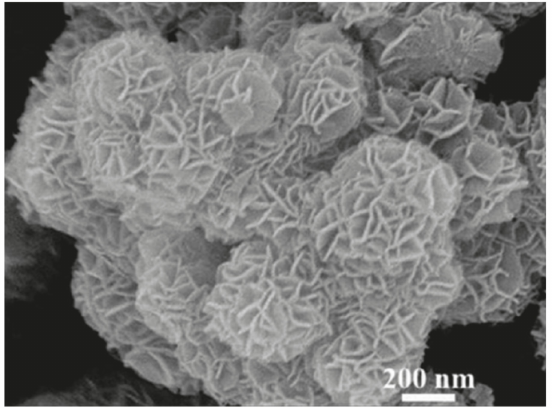
Figure 4. SEM image of a nanoflower α -MnO 2 [19]. Reprinted with permission from [19]. Copyright 2010 American Chemical